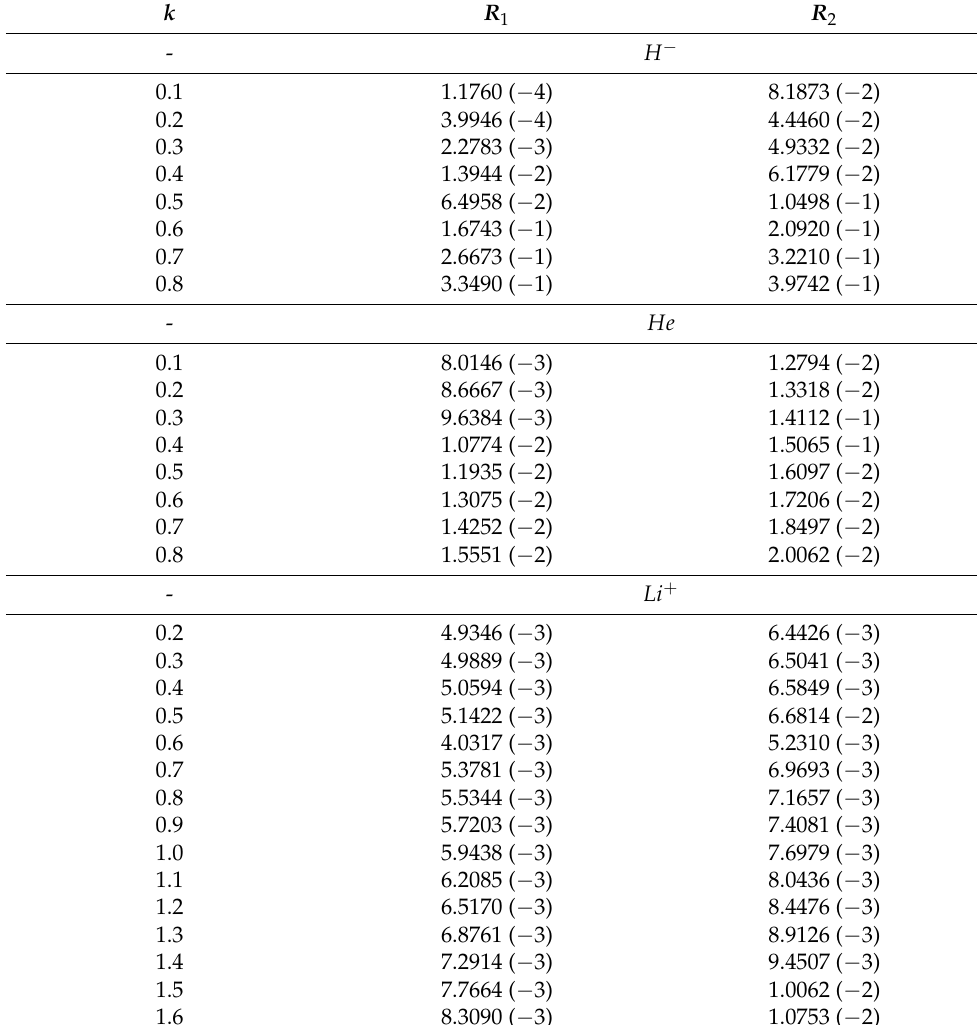
Table 8. Ratios R 1 and R 2 .